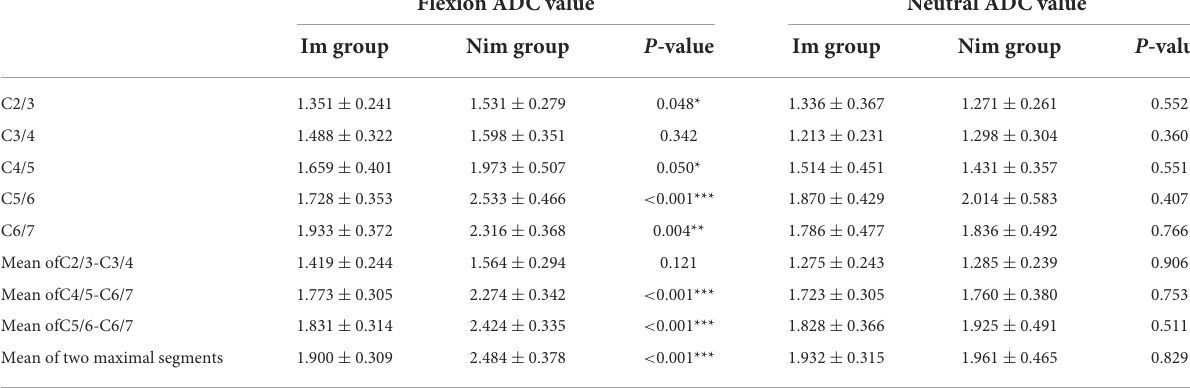
TABLE 5 Comparison of flexion and neutral ADC values between the two groups of patients.